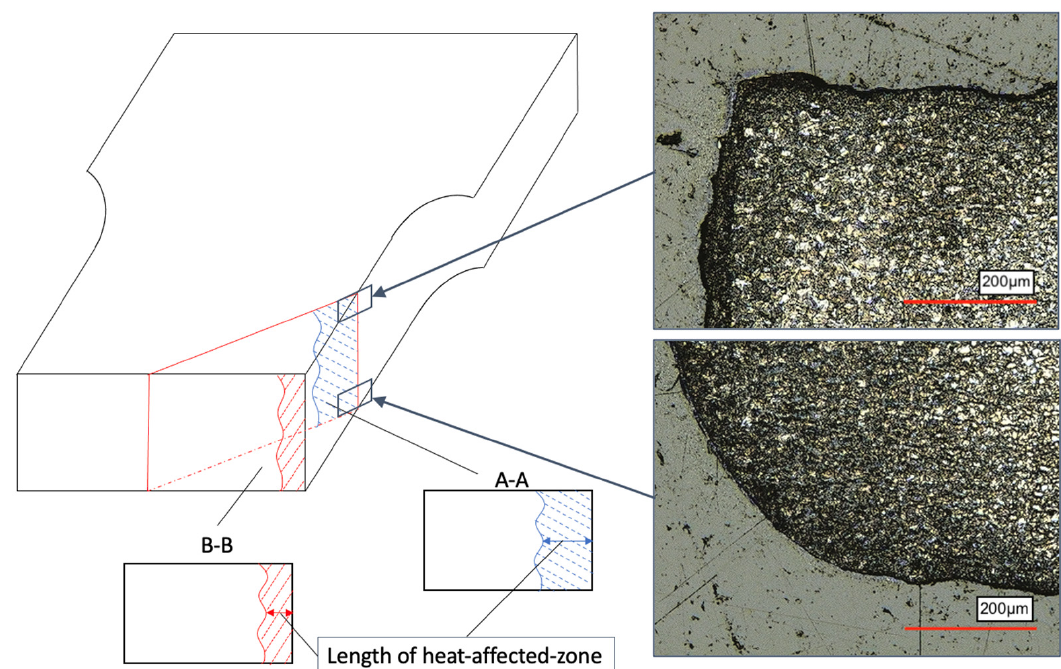
Figure 3. Microstructure of polished inclined cross section. Top side edge with sharp corner (flame entry) and more round edge on bottom side.